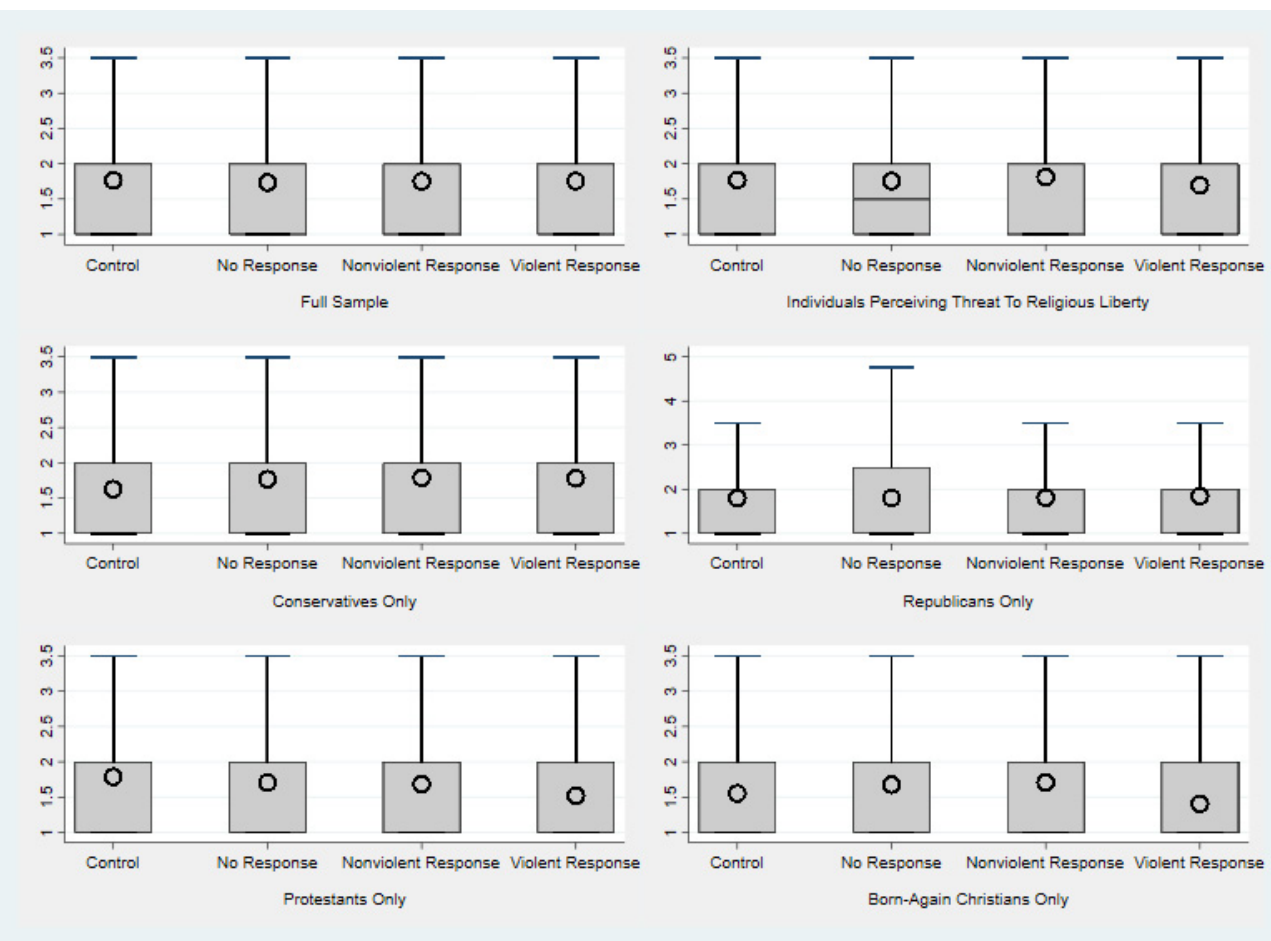
Figure 4. The causal effects of persecution discourse on support for political violence across conditions and by sample. The top left panel illustrates the effects of persecution discourse on the full sample’s support for political violence. The top right panel illustrates the effects of persecution discourse on the religious liberty threat perception subsample’s support for political violence. The middle-left panel illustrates the effects of persecution discourse on the conservative subsample’s support for political violence. The middle-right panel illustrates the effects of persecution discourse on the Republican subsample’s support for political violence. The bottom left panel illustrates the effects of persecution discourse on the Protestant subsample’s support for political violence. The bottom right panel illustrates the effects of persecution discourse on the born-again Christian subsample’s support for political violence. For comparisons, refer to Appendix C. Key : boxes represent the interquartile range; circles represent the mean; thick lines represent the median; whiskers represent minimum and maximum values.